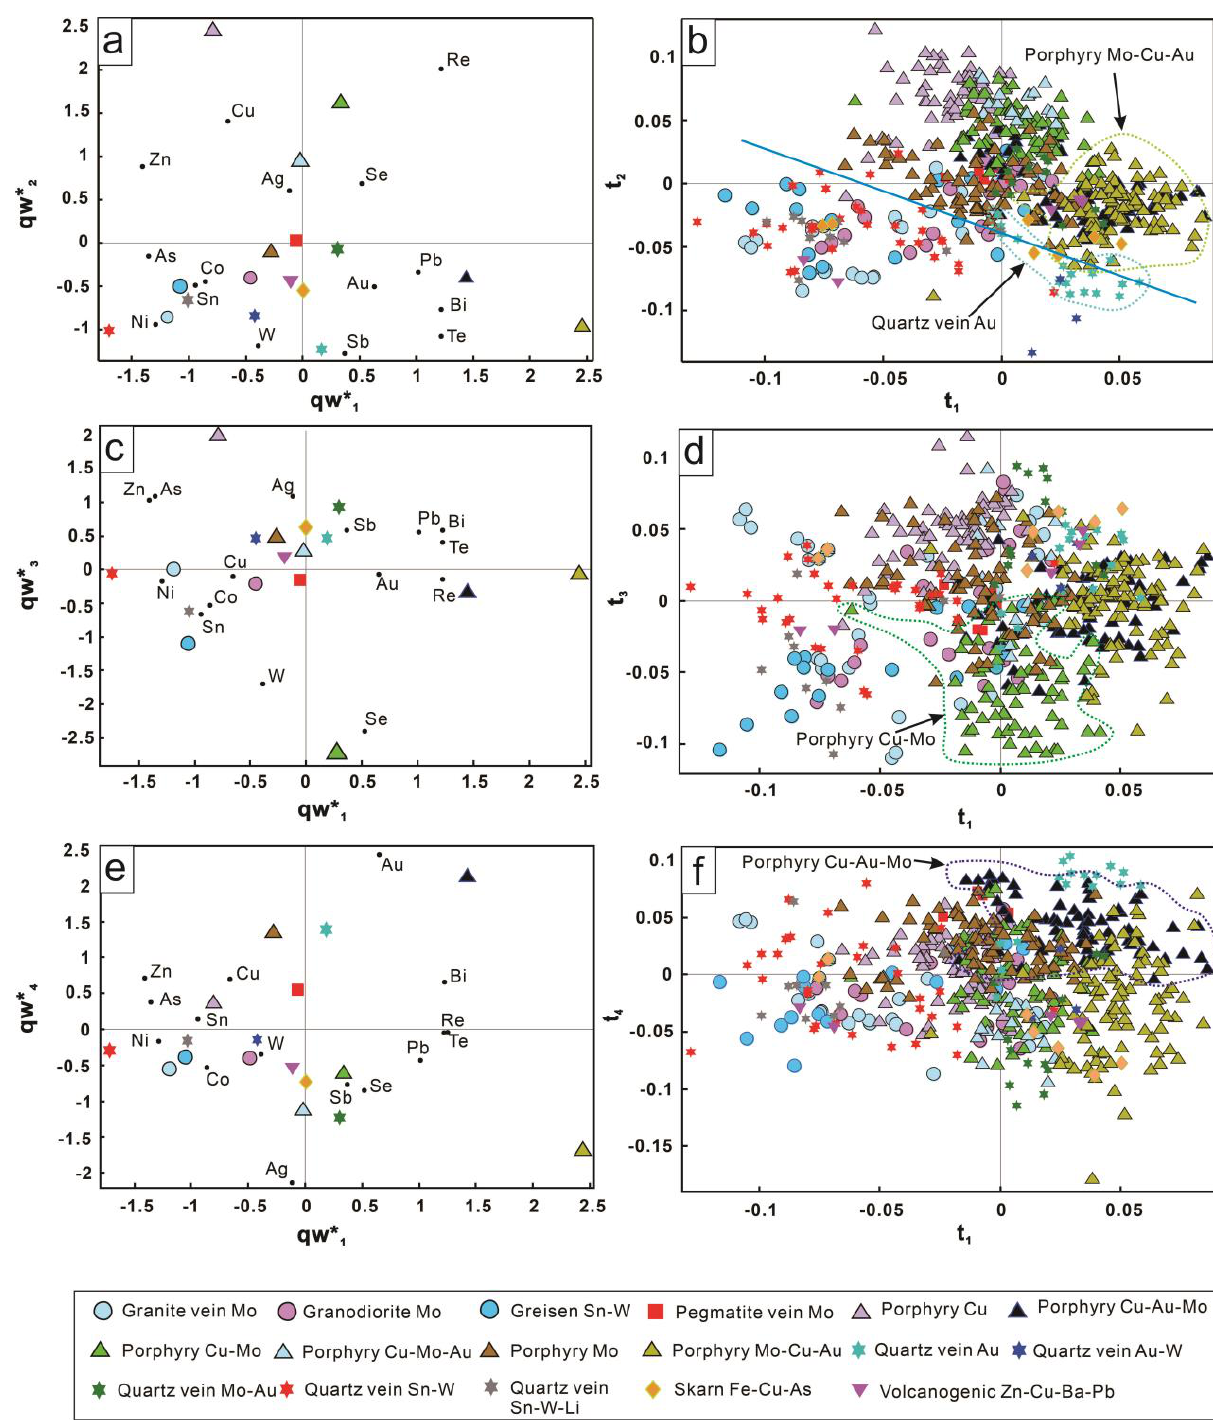
Figure 2. Multi-element box and whisker plots for LA –ICP‒MS trace element data (ppm) of molyb- denite from seventeen deposit types. See detailed explanation in text.